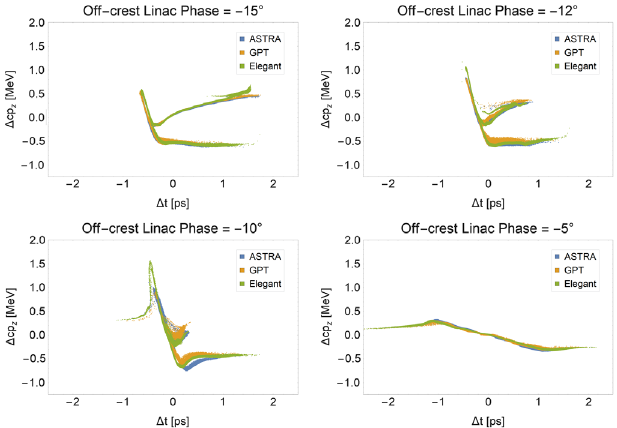
FIG. 7. Comparison of the simulated longitudinal phase space at the BA1 interaction point between ASTRA , ELEGANT , and GPT for various linac 1 off-crest phases and with space-charge forces included but no CSR effects. Maximum compression was experimentally measured around − 12 ° off crest in linac 1. In all simulations, we utilize the same ASTRA -based photo-